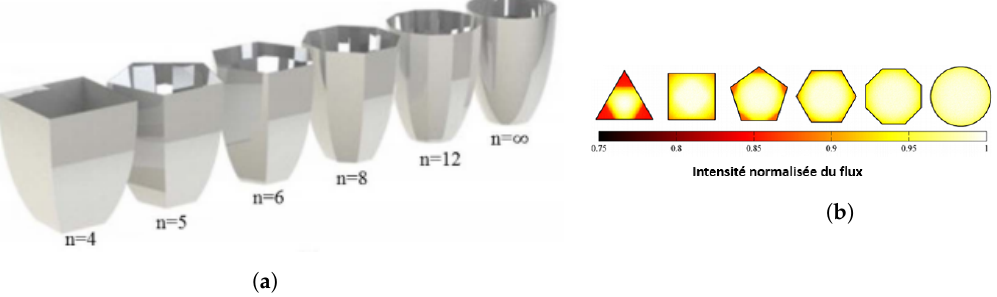
Figure 20. Shapes of CPC: from CCPC ( n = 4) to CPC ( n = ∞ ) [29]. Reprinted from M. Tian et